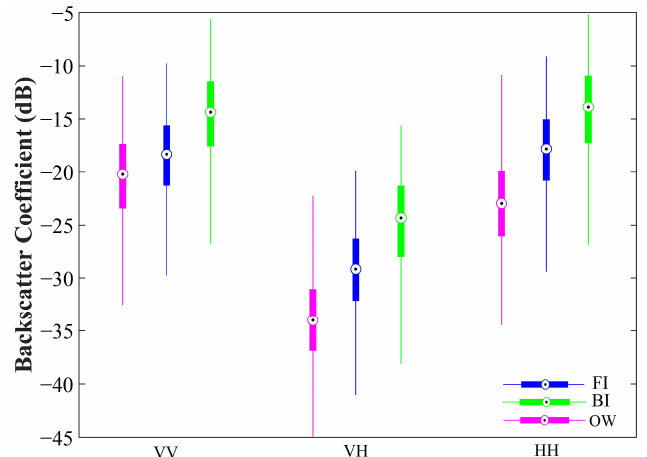
Figure 8. The backscatter coefficient statistics for FI, brash ice (BI), and open water (OW) in the R3 region.